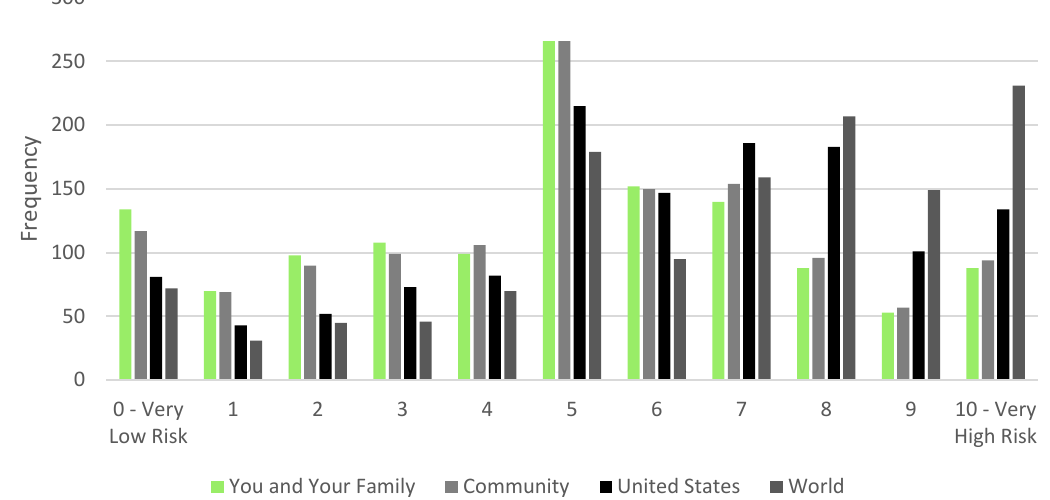
Figure 1. Perceptions of the health risk caused by climate change by geographical